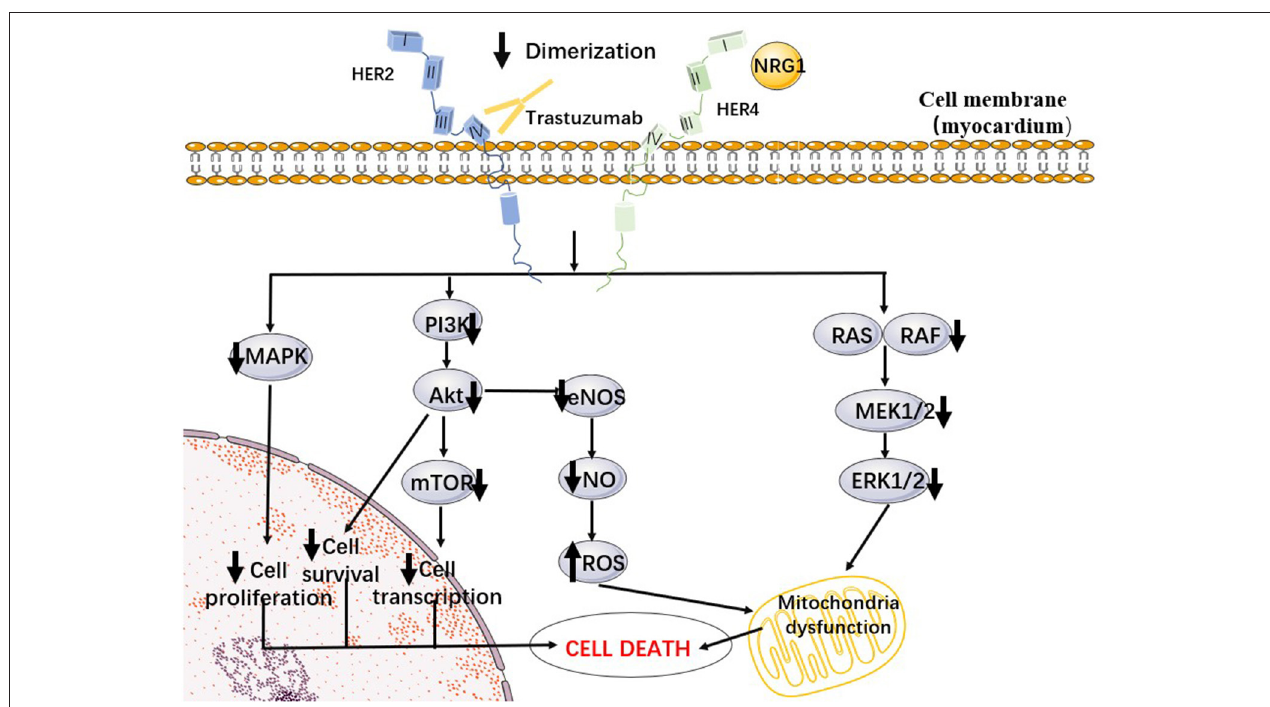
FIGURE 1 | A proposed cellular mechanism of the cardiotoxicity of trastuzumab. Trastuzumab inhibited Her2/4 dimerization, preventing autophosphorylation and subsequent downstream pathways such as PI3K/Akt and MAPK.